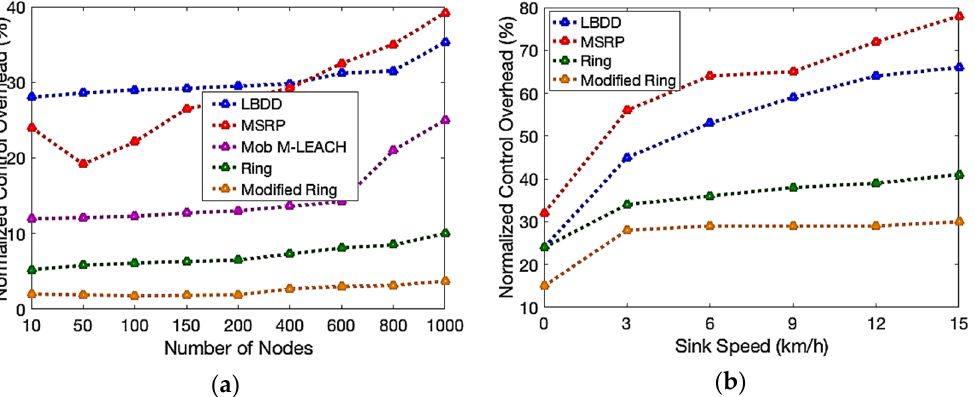
Figure 13. Control overhead analysis; ( a ) variation in the network density; ( b ) variation in the sink speed.